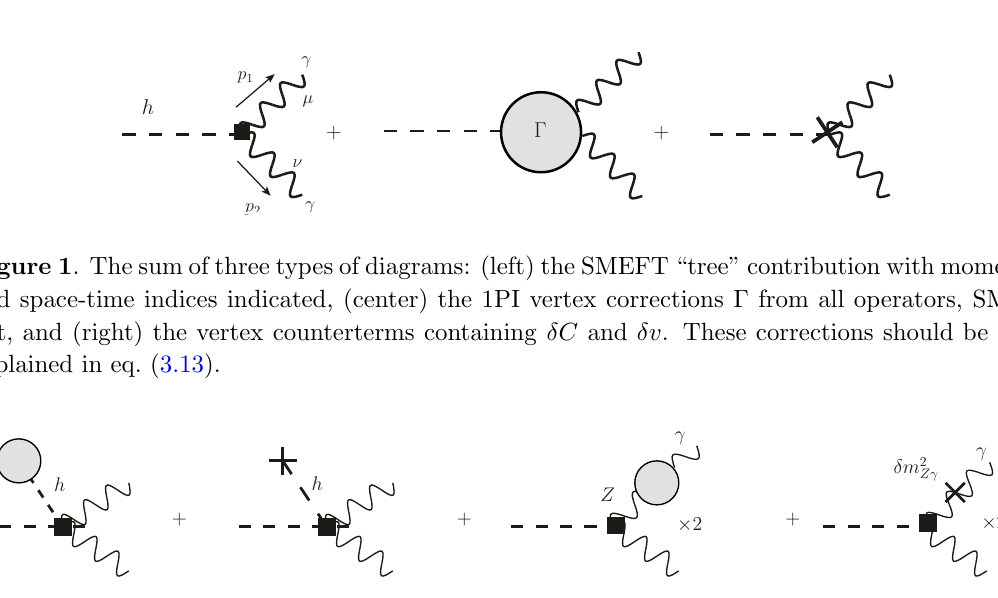
Figure 2 . Tadpole and Z(cid:13) self-energy contributions with their associated counterterms. Crosses denote SM counterterms and the black boxes indicate pure d = 6 operator